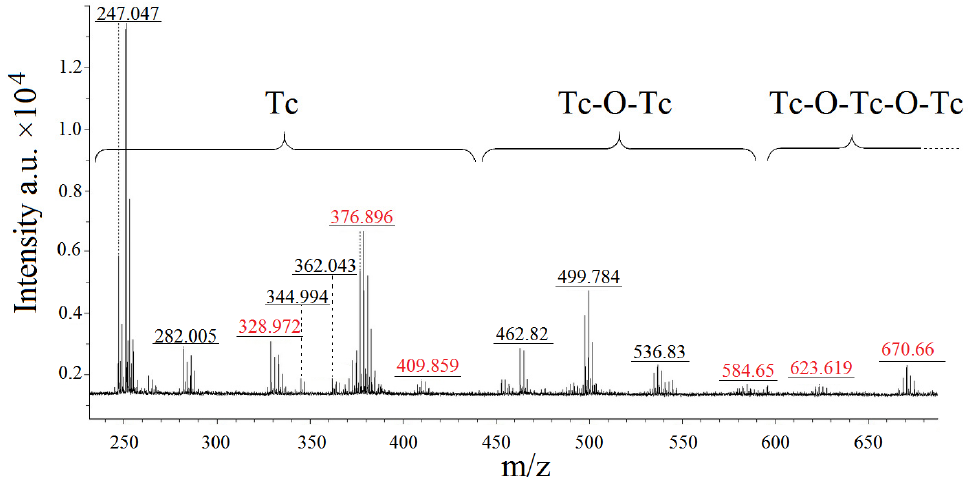
Figure 7. MALDI spectroscopy of the stock solution of compound 1 . According to the quantity of technetium atoms, the peaks in the spectrum were split into three groups. Complexes with only one technetium atom in their structure belong to the first category, which spans the 247–440 a.m.u. range. Peaks 247.047 a.m.u. (calc. 246.05) and 282.005 a.m.u. (calc. 281.98) correspond to particles with the gross formulas TcO 2 ClN 2 C 4 H 5 and TcO 2 Cl 2 N 2 C 4 H 5 , respectively. Since each of these particles contains one heterocyclic fragment, it is possible that the formation of particles with only one heterocyclic fragment in their structure is one of the initial steps in the reaction for compound 1 . The gross formulas for the peaks at 344.94 a.m.u. (calc.344.97) and 362.043 a.m.u. (calc.361.99) are TcOCl 2 N 4 C 8 H 8 and TcO 2 Cl 2 N 4 C 8 H 9 , respectively. The particles include two heterocycles, and the structures differ by one OH